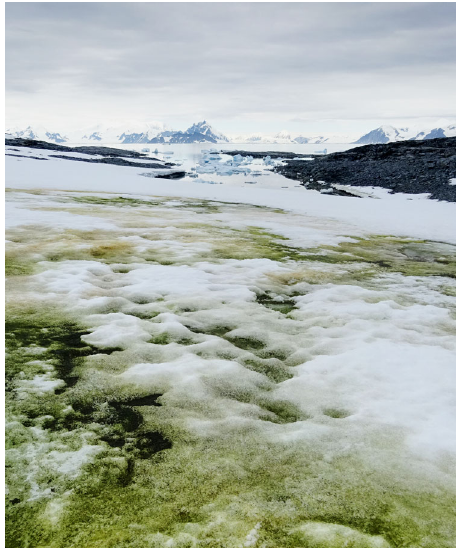
Fig. 1 Green snow algae. A photograph showing a snow algae bloom dominated by green algae starting to melt out from beneath seasonal snow cover to sit exposed upon underlying multiyear n (cid:1) ev (cid:1) e/ fi rn. 26 January 2018, Anchorage Island (67.6°S). Bloom shown was approximately